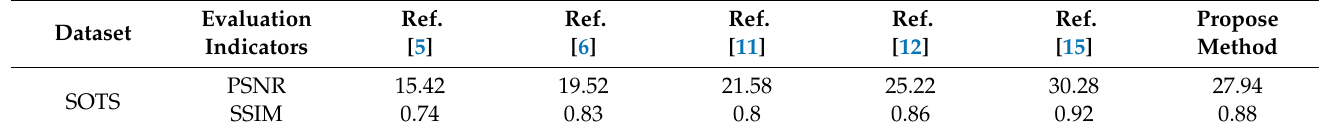
Table 1. The quantitative evaluation of different defogging methods on the SOTS dataset.